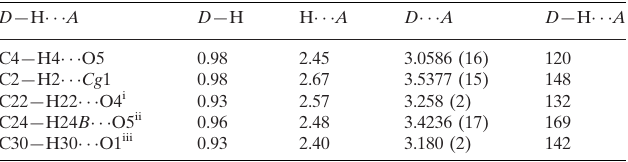
Hydrogen-bond geometry (A˚ , (cid:2)